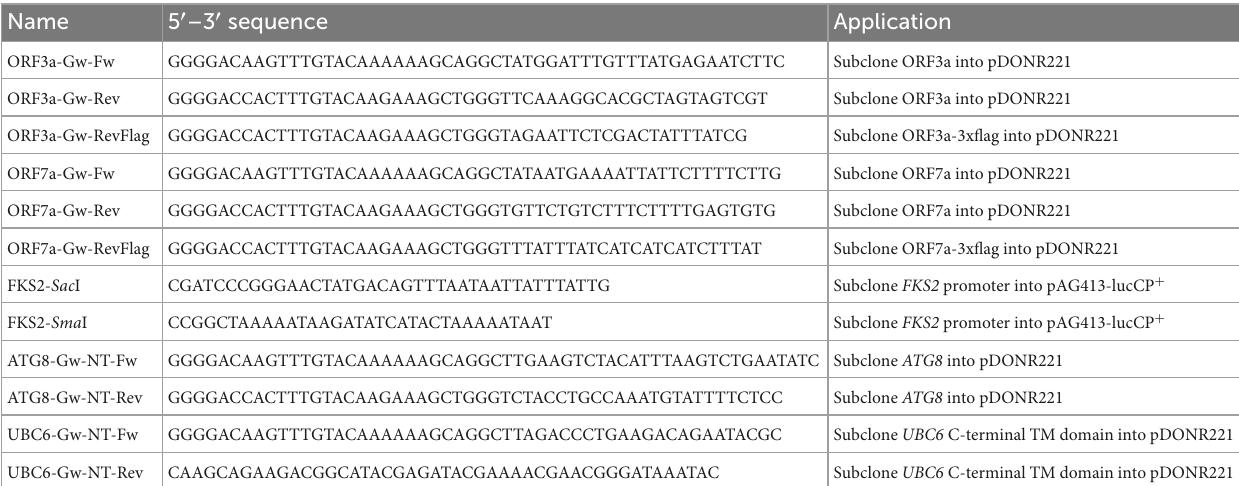
TABLE 2 Oligonucleotide primers used in this